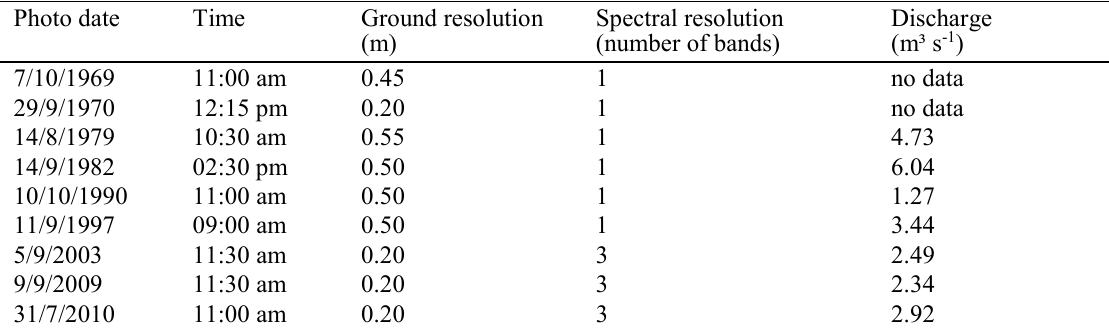
Table 1 Orthophoto meta data; spectral resolution is the number of bands. 1 is panchromatic and 3 is multispectral (red-green-blue); discharge data were recorded at gauging station Gepatschalm (operated by